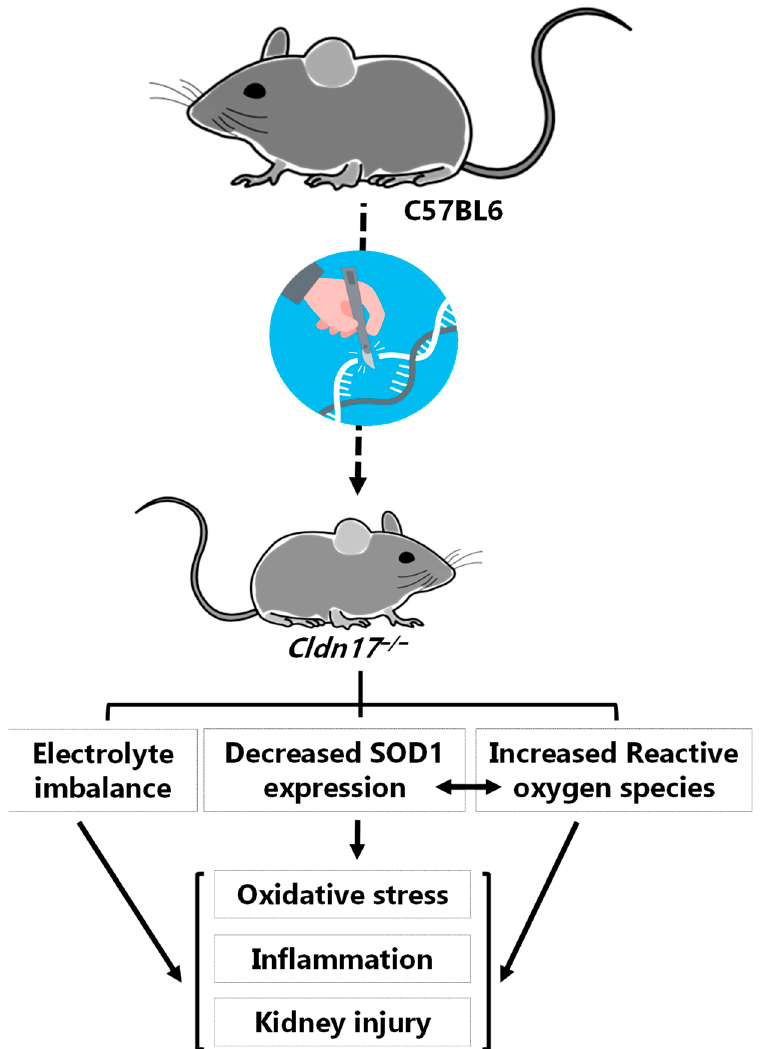
Figure 8. Cldn17 deficiency results in kidney injury as a result of an imbalance in electrolytes and increased ROS levels associated with reduced expression of SOD1 and modulation of a few other genes that are involved in ROS generation, leading to oxidative stress, inflammation, and kidney injury in mice. Pharmacological interventions to prevent the loss of Cldn17 or increase its expression may have therapeutic benefits for kidney and other organ injuries.